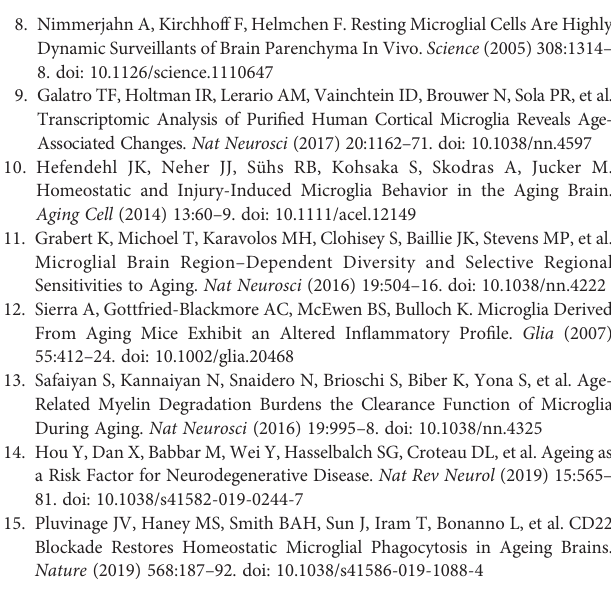
Supplementary Video 1 | Time-lapse of activated microglia at the slice surface. Scale bar: 20 µm. Supplementary Video 2 | Two-photon Z-scan through the acute slice, starting at the slice surface until a depth of -111 µm. Scale bar: 20 µm. Supplementary Video 3 | Montage of time-lapse (left) and cumulative surveilled area over time (right) of a homeostatic microglia. Scale bar: 20 µm. Supplementary Video 4 | Two-photon recording of homeostatic microglia at a depth of -80 µm. Scale bar: 20 µm. Supplementary Video 5 | Two-photon time-lapse of homeostatic microglia in vivo. Scale bar: 20 µm. Supplementary Video 6 | 10µM NBQX provokes a severe microglial de- rami fi cation when applied on the acute slice. Scale bar: 20 µm. Supplementary Video 7 | Time-lapse of microglia experiencing abolishment of process dynamics upon wash-in of 1µM cytochalasin B. Scale bar: 20 µm. Supplementary Video 8 | During wash-in of 1mM ATP, microglia react immediately by hyper-rami fi cation and temporal development of bulbous tips. Scale bar: 20 µm. Supplementary Video 9 | Two-photon recording of microglia from an adult mouse under steady-state conditions. Scale bar: 20 µm. Supplementary Video 10 | Time-lapse of an aged microglia demonstrating age- associated hypo-rami fi cation. Scale bar: 20 µm. Supplementary Video 11 | No evident differences can be observed in adult microglia after treatment with IgG antibody. Scale bar: 20 µm. Supplementary Video 12 | Upon pre-treatment with the CD22 antibody, no changesinmicrogliadynamicsarevisibleinmicrogliafromadultmice.Scalebar:20µm. Supplementary Video 13 | After IgG control antibody incubation, reduced rami fi cation of aged microglia remains unaffected. Scale bar: 20 µm. Supplementary Video 14 | Antibody-mediated CD22-blockage reverses the age-related hypo-rami fi cation of aged microglia. Scale bar: 20